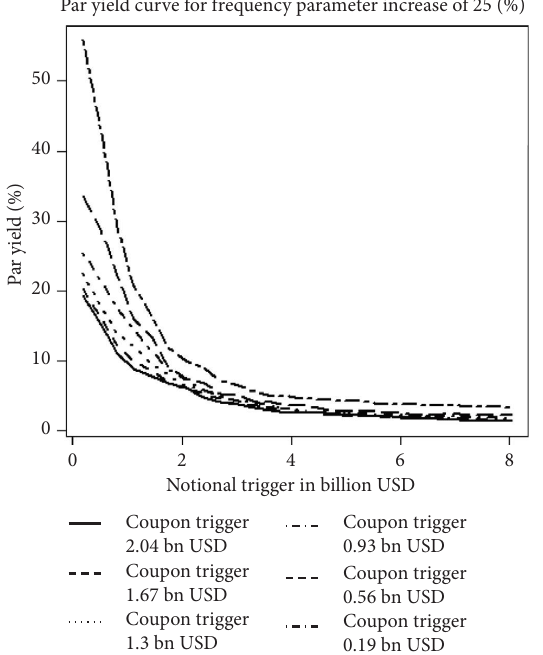
Figure 23: Cyber bond par yield curve for loss frequency parameter λ increase of 25%.